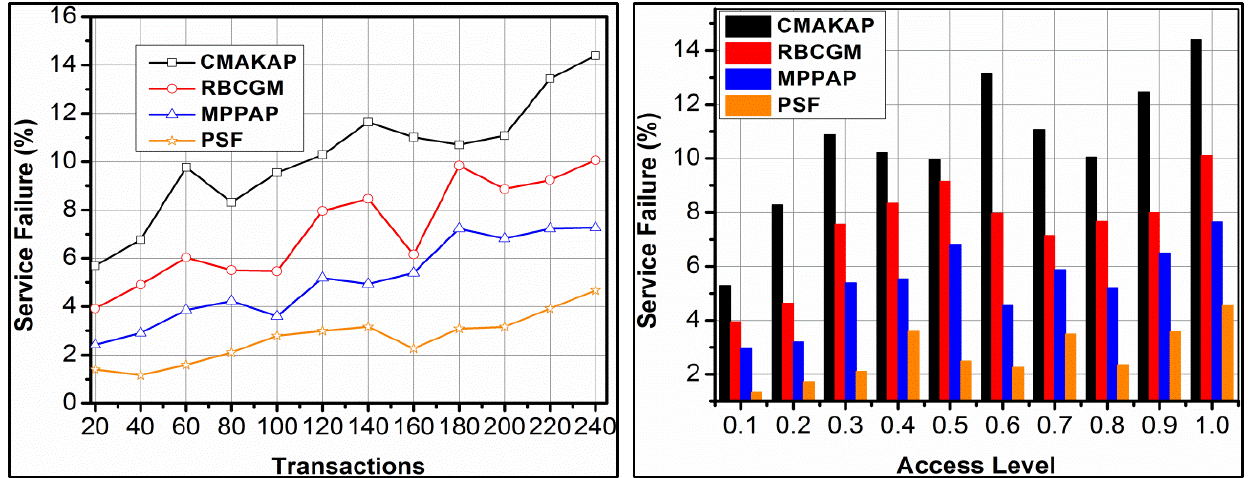
Figure 8. Service failure analysis.